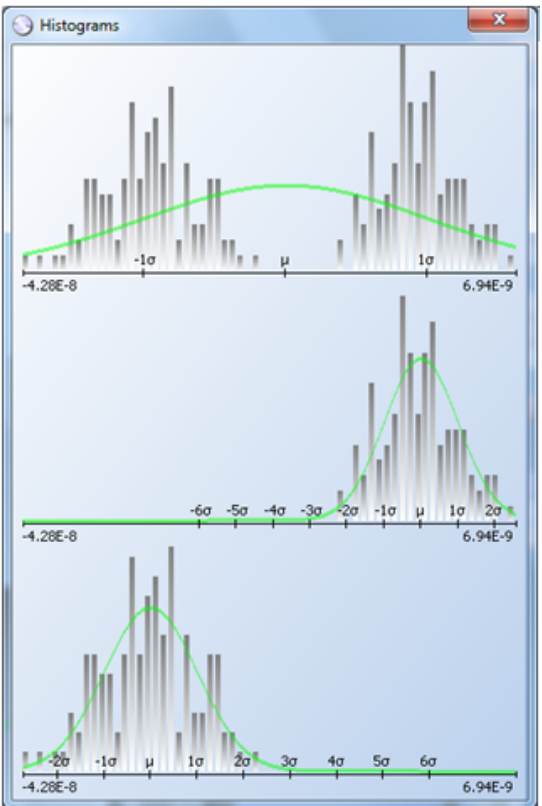
Figure 13. Multi-site